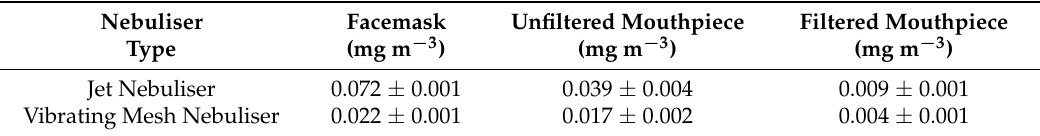
Table 2. Thirty-minute averaged aerosol concentration during each nebulisation event (using different facemasks and mouthpieces); mean and standard deviations over the three